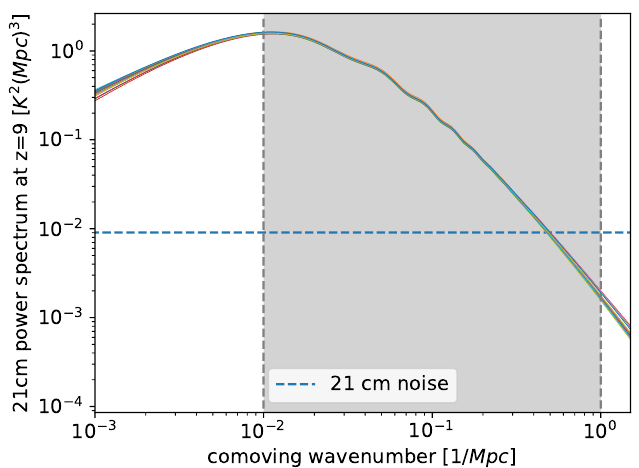
Figure 7: Comparison between 21cm power spectrum and the noise power spectrum computed through Eq.(20). The gray lines denote the maximal and minimal scales considered.